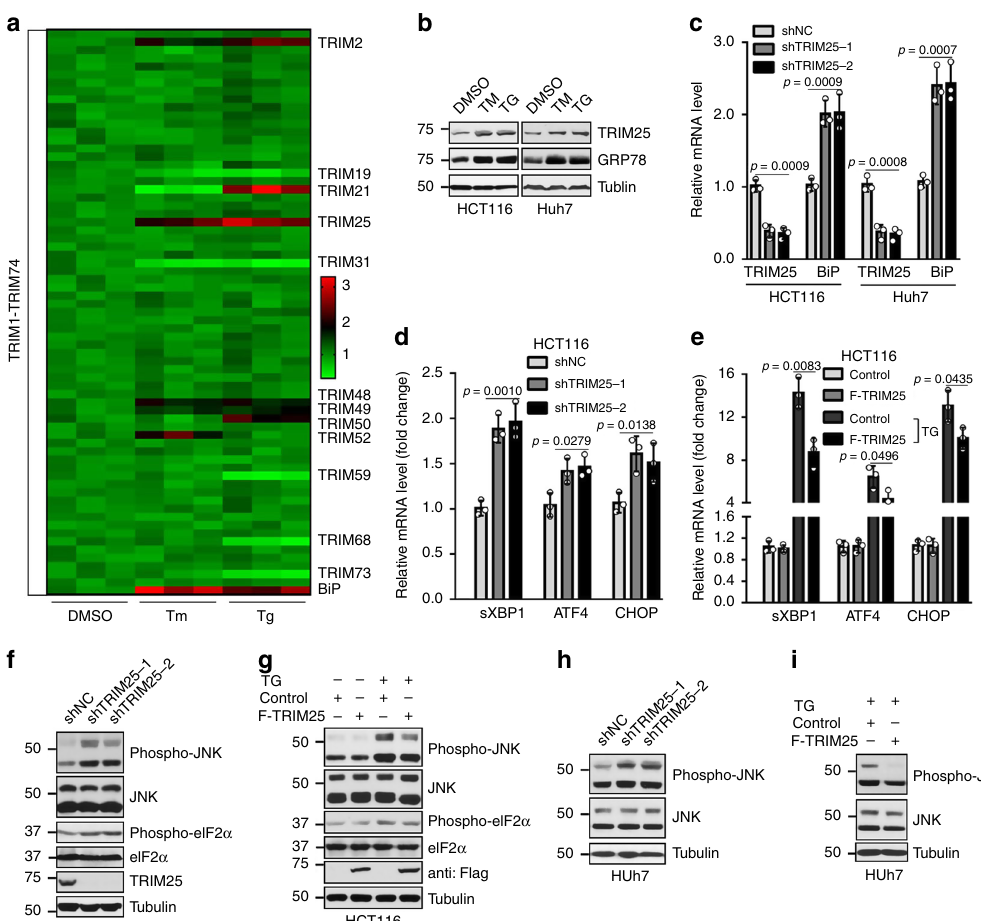
Fig. 1 TRIM25 functions as a feedback mechanism that responds to ER stress in tumor cells. a Relative mRNA fold change of all TRIMs in HCT116 cells treated with TM (Tunicamycin, 5 μ g/ml) or TG (Thapsigargin, 1 μ M) for 6 h. b Western blot analysis the level of TRIM25 and GRP78 in HCT116 and Huh7 cells treated with TM (5 μ g/ml) or TG (1 μ M) for 12 h. c Relative mRNA fold change of TRIM25 and BiP genes in HCT116 and Huh7 cells after stable knockdown of TRIM25. d Relative mRNA fold change of UPR genes: sXBP1, ATF4, CHOP in HCT116 cells with control (shNC) or stable knockdown of TRIM25. e Relative mRNA fold change of UPR genes: sXBP1, ATF4, CHOP in HCT116 cells stably overexpressing control or F-TRIM25 (Flag-TRIM25), treated with or without TG (1 μ M) for 6 h. f Western blot analysis of UPR signaling, including phospho-JNK/JNK and phospho-eIF2 α /eIF2 α in HCT116 cells after stable knockdown of TRIM25 in HCT116 cells. g Western blot analysis of the levels of phospho-JNK/JNK andphospho-eIF2 α /eIF2 α in HCT116 cells overexpressing control or F-TRIM25, treated with or without TG (1 μ M) for 12 h. h , i Western blot analysis of the levels of phospho-JNK/JNK in Huh7 cells after stable knockdown ( h ) or overexpression ( i ) of TRIM25, treated with or without TG (1 μ M) for 12 h. For c – e , data represent the mean ± SEM ( n = 3). Statistical signi fi cance was assessed using two-tailed Student ’ s